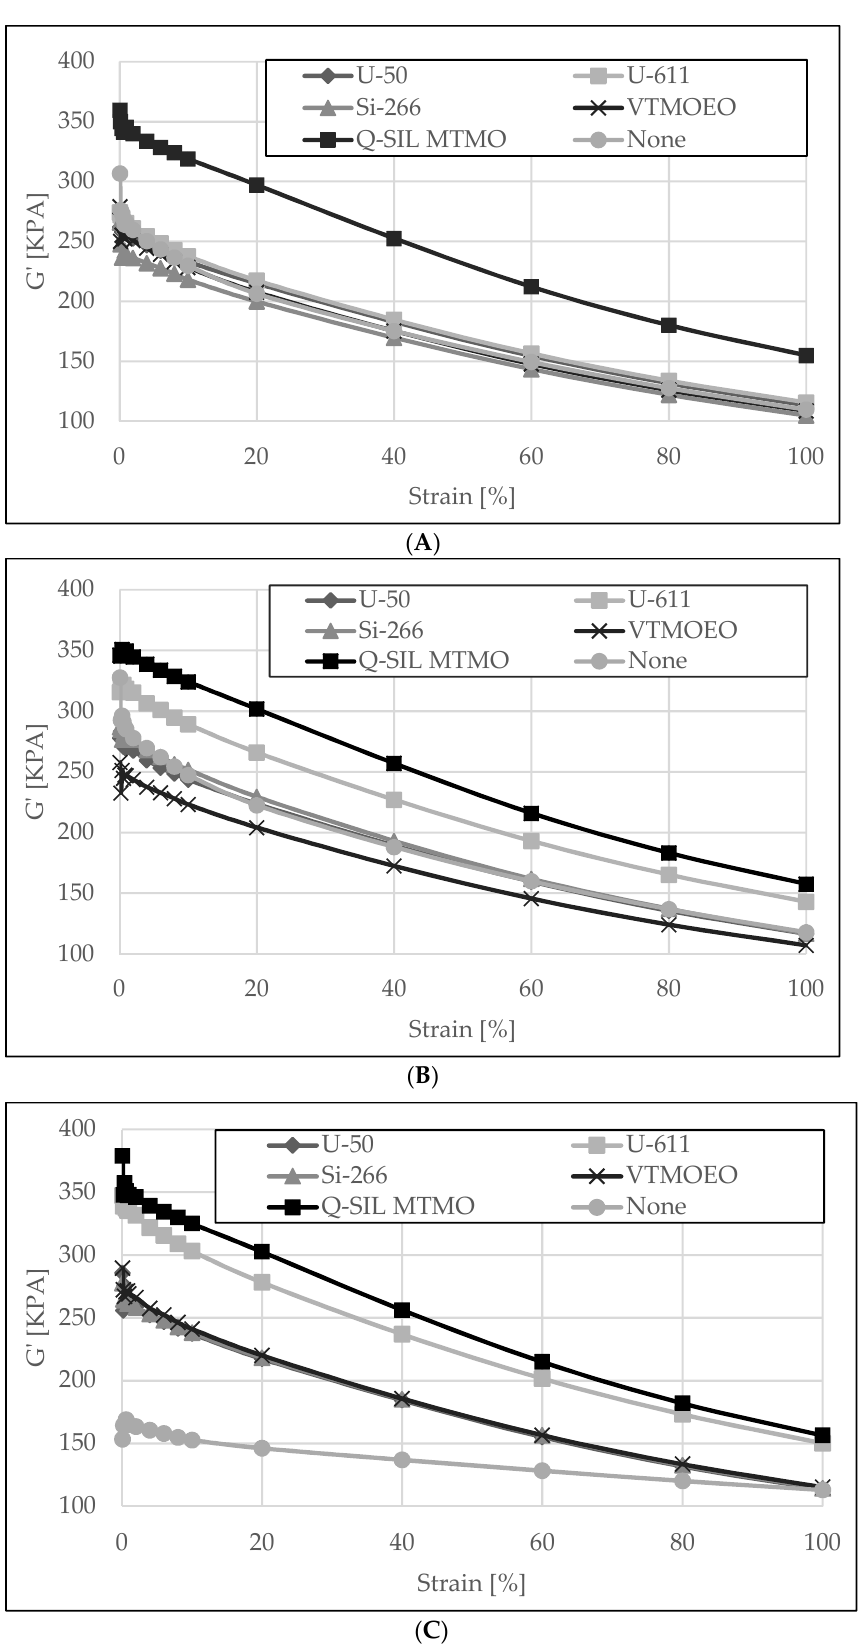
Figure 7. Payne effect for the rubber compounds filled with 30 phr of N-220 and 20 phr of unmodified or silanized: ( A ) FA-63; ( B ) FA-125; ( C ) FA-250.